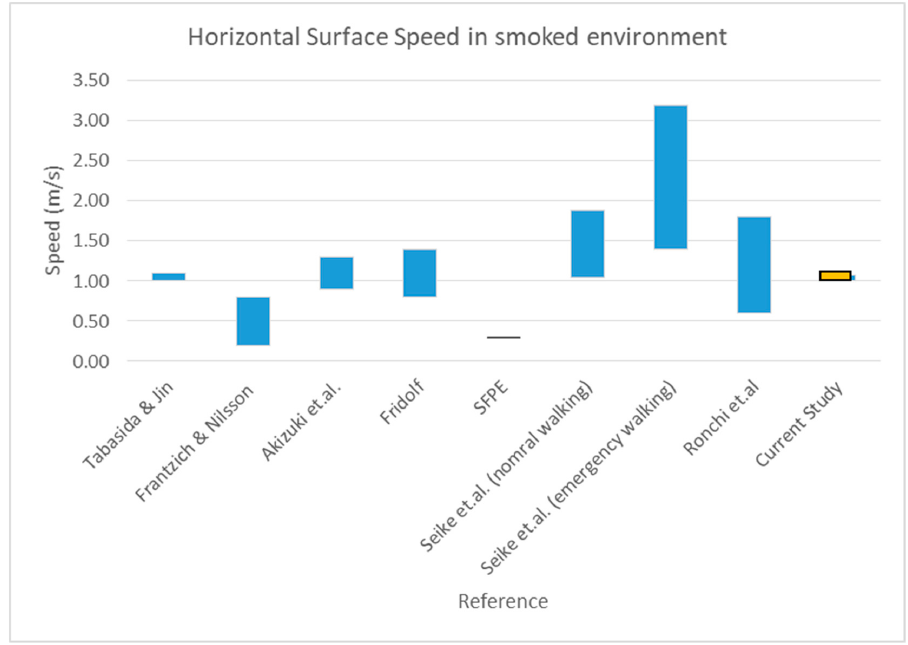
Figure 22. Walking speed (m/s) during evacuation in smoke-filled environments—previous and current experiment.